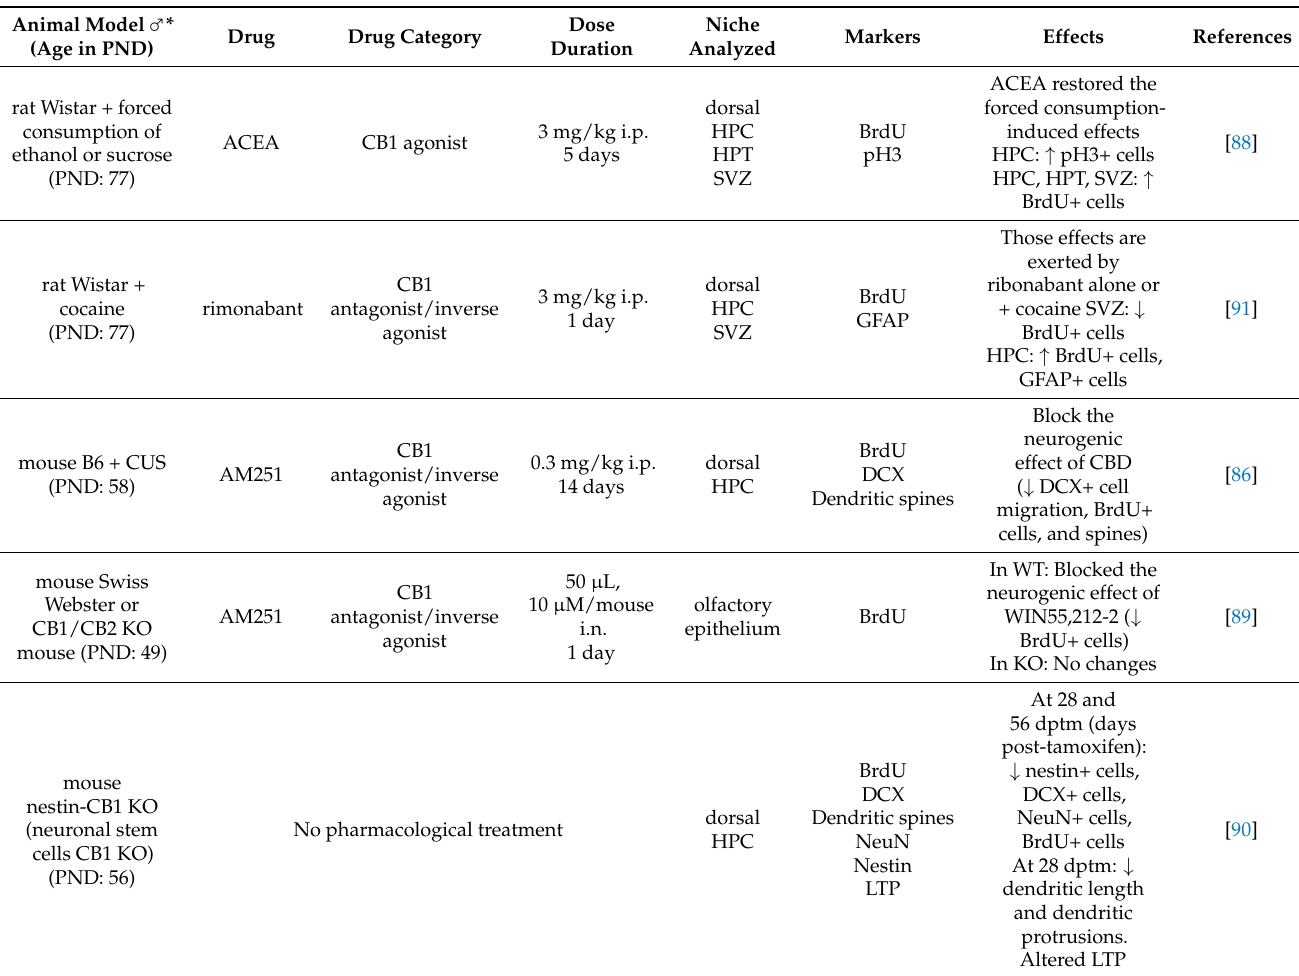
Table 4. Effects of CB1 modulation on